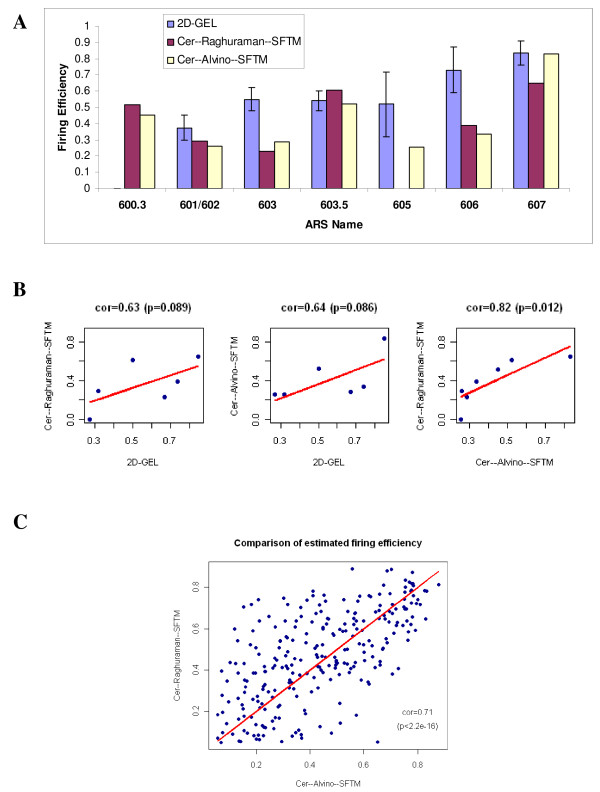
Comparison of estimated firing efficiencies of origins in S.cerevisiae. (A) Estimated firing efficiencies of origins on Chromosome VI of S.cerevisiae. The height of the vertical bar shows our estimation by applying the proposed SFTM to two microarray timecourse data sets (Cer-Raghuraman and Cer-Alvino) and Friedman's estimation by using 2-D gel electrophoresis [7]. The error bar of 2-D gel estimation reflects the variation in firing efficiencies among different strains. (B) Pairwise scatter plots of origin firing efficiencies estimated from three sources in (A). The correlation coefficients are shown at the top of the respective figures. The good consistency between these results suggests that SFTM is a valid method to estimate firing efficiency. (C) Scatter plot of the estimated firing efficiencies of the matched origins from two S.cerevisiae data sets Cer-Raghuraman and Cer-Alvino by applying SFTM.